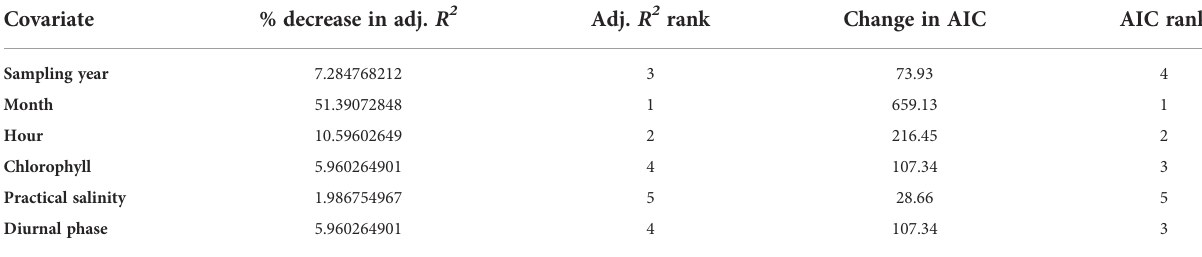
TABLE 2 The relative in fl uence of model covariates for explaining the harbour porpoise activity patterns. Covariate % decrease in adj. R 2 Adj. R 2